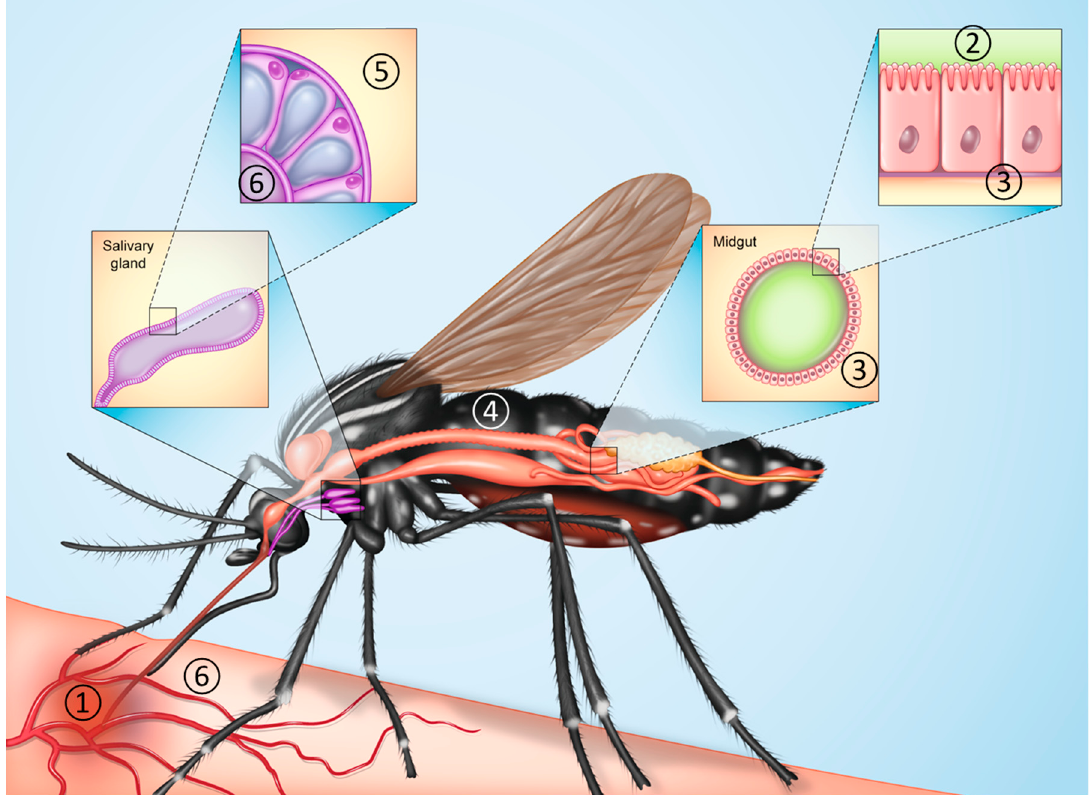
Figure 1. Sequential steps required for a female mosquito to transmit a virus biologically. ( 1 ) The virus in question is imbibed by a female mosquito from an viremic host, ( 2 ) the virus infects and replicates in midgut epithelial cells (overcoming the midgut infection barrier), ( 3 ) the virus escapes from midgut epithelial cells into the mosquito’s hemolymph within the hemocoel (overcoming the midgut escape barrier to develop a disseminated infection), ( 4 ) the infection of and replication in peripheral tissues / organs such as nerves, muscle fibers, or fat body, ( 5 ) the infection of salivary glands (this step can potentially occur in the absence of infection / replication of peripheral tissues / organs, overcoming the salivary gland infection barrier), and ( 6 ) shedding into the apical cavities of acinar cells and presence in the saliva for inoculation into subsequent hosts upon feeding [31,34,35].